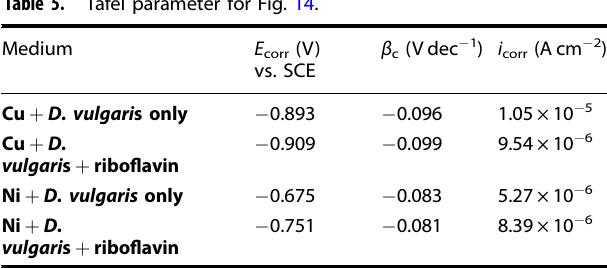
Fig. 15 Schematic. Schematic of a comparison of EET-MIC of Ni ( a ) with ribo fl avin as an electron mediator and M-MIC of Cu ( b ) by D. vulgaris bio fi Table 5. Tafel parameter for Fig. 14.